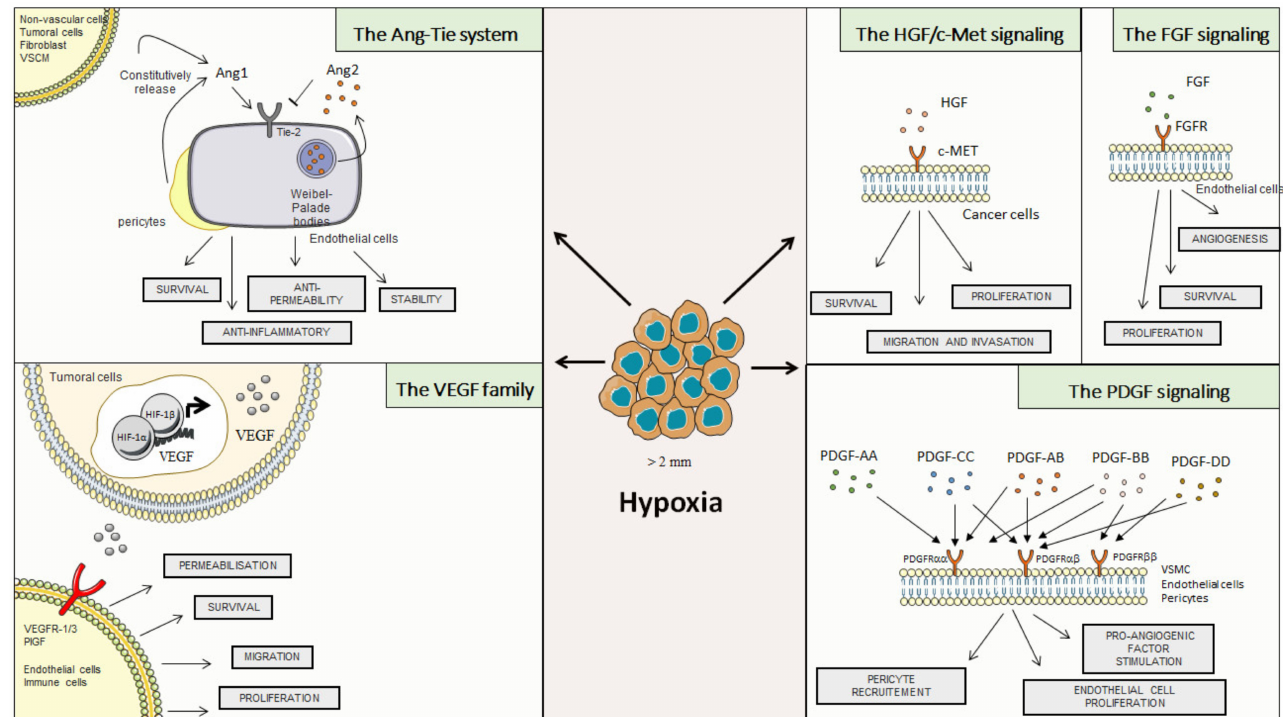
Figure 2. Role of classical regulators of